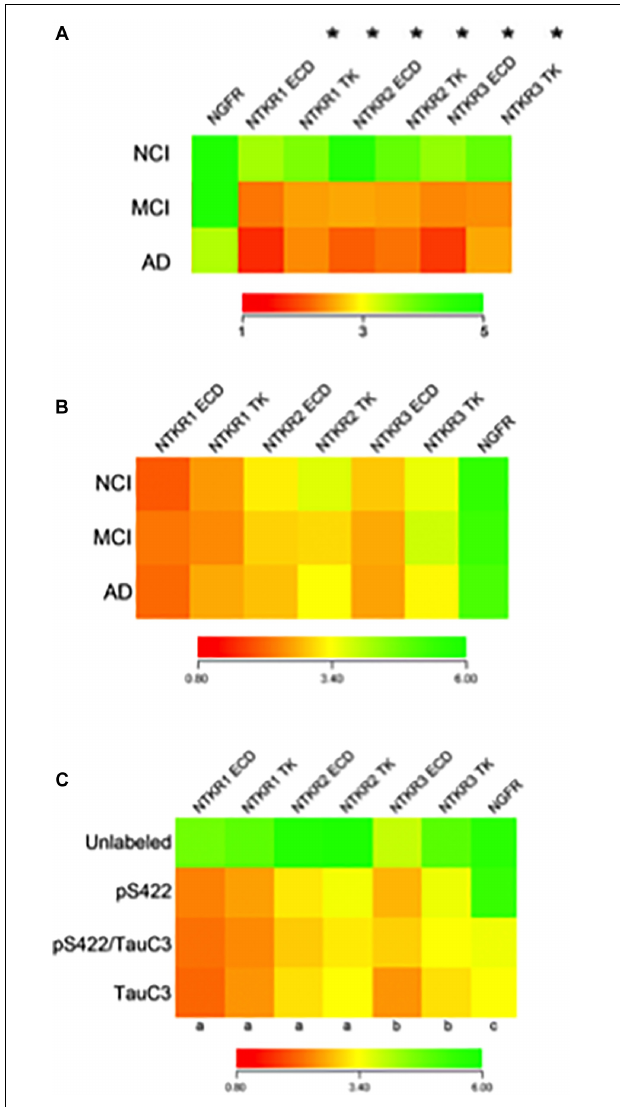
FIGURE 9 | Findings derived from single cholinotrophic neuron profiling during the progression of AD. (A) Heatmap demonstrating downregulation of Ntrk1 (TrkA), Ntrk2 (TrkB), and Ntrk3 (TrkC) {both the extracellular domain (ECD) and the tyrosine kinase domain (TK)} (asterisk), but not Ngfr (p75 NTR ) during the progression of dementia. Trk gene expression in MCI is intermediate to AD, indicating a step-down effect from NCI to MCI to AD. (B) Heatmap of the relative expression profiles for select neurotrophin transcripts in pS422+ nbM neurons. No differences in Trk receptors or Ngfr were found in MCI or AD compared to NCI. (C) Downregulation of Trk receptors was found in pS422+ nbM neurons compared to unlabeled control neurons. Downregulation of Ngfr was associated with the neoepitope TauC3. Key: (a) unlabeled > pS422, p < 0.001; (b) unlabeled > pS422, p < 0.01; (c) pS422 > pS422+/TauC3+, p < 0.01. (A) Adapted with permission from Ginsberg et al. (2006b). (B,C) Adapted with permission from Tiernan et al. (2018a).